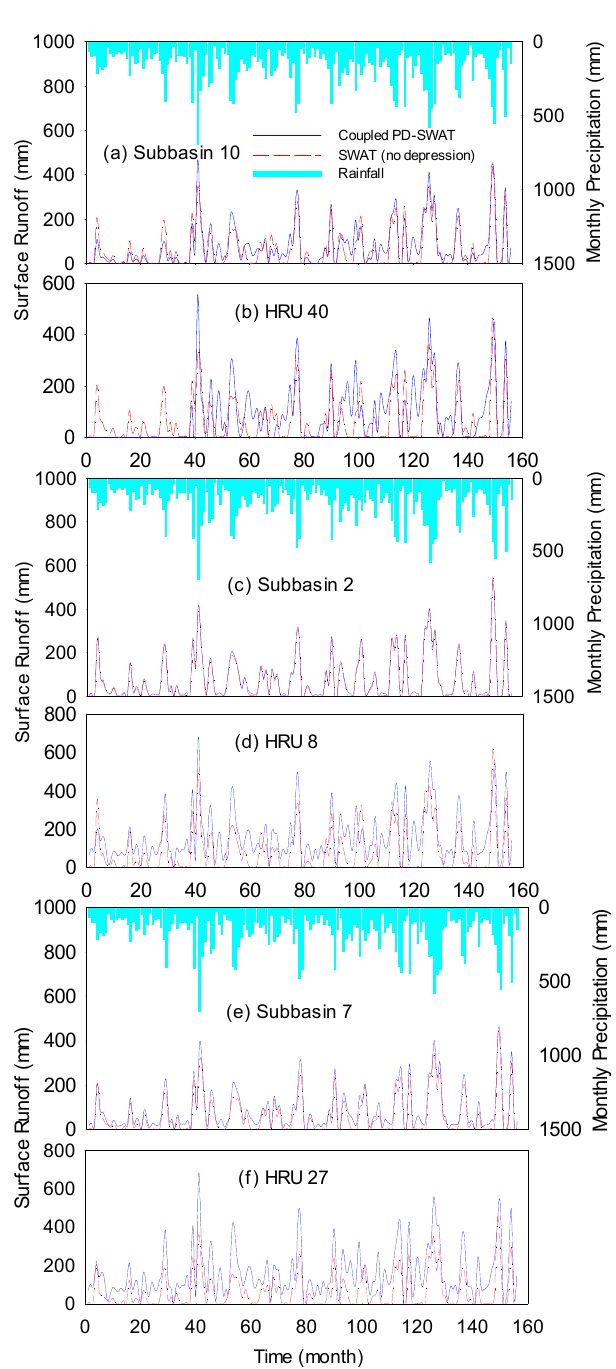
Figure 6. Comparison of surface runoff simulated by the coupled PD-SWAT and SWAT for three selected sub-basins and their typical HRUs with depressions under extreme high precipitation: ( a ) sub-basin 10 (depression-dominated sub-basin); ( b ) HRU 40 in sub-basin 10; ( c ) sub-basin 2 (lowest depression coverage); ( d ) HRU 8 in sub-basin 2; ( e ) sub-basin 7; and ( f ) HRU 27 in sub-basin 7.